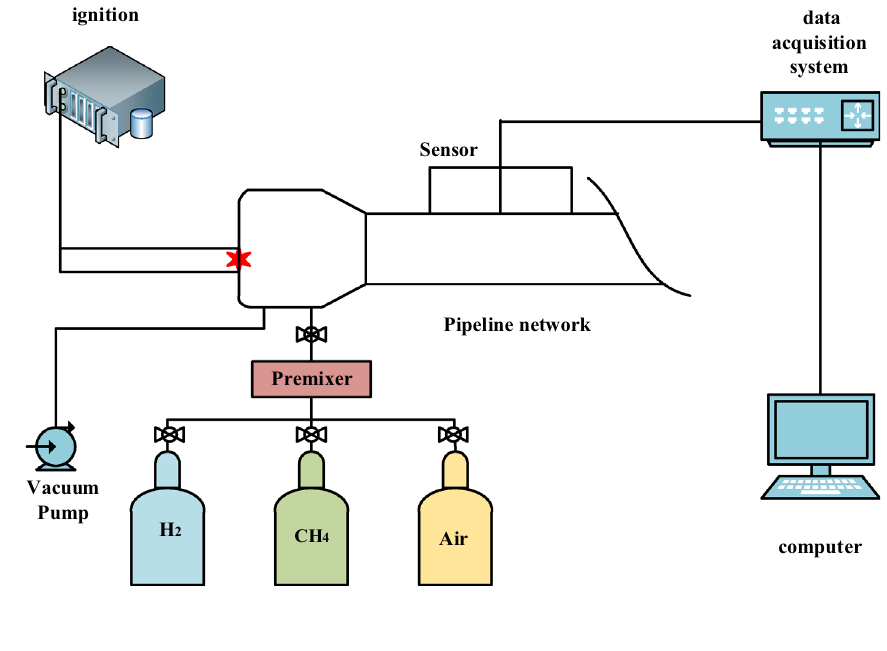
Figure 1. Experimental